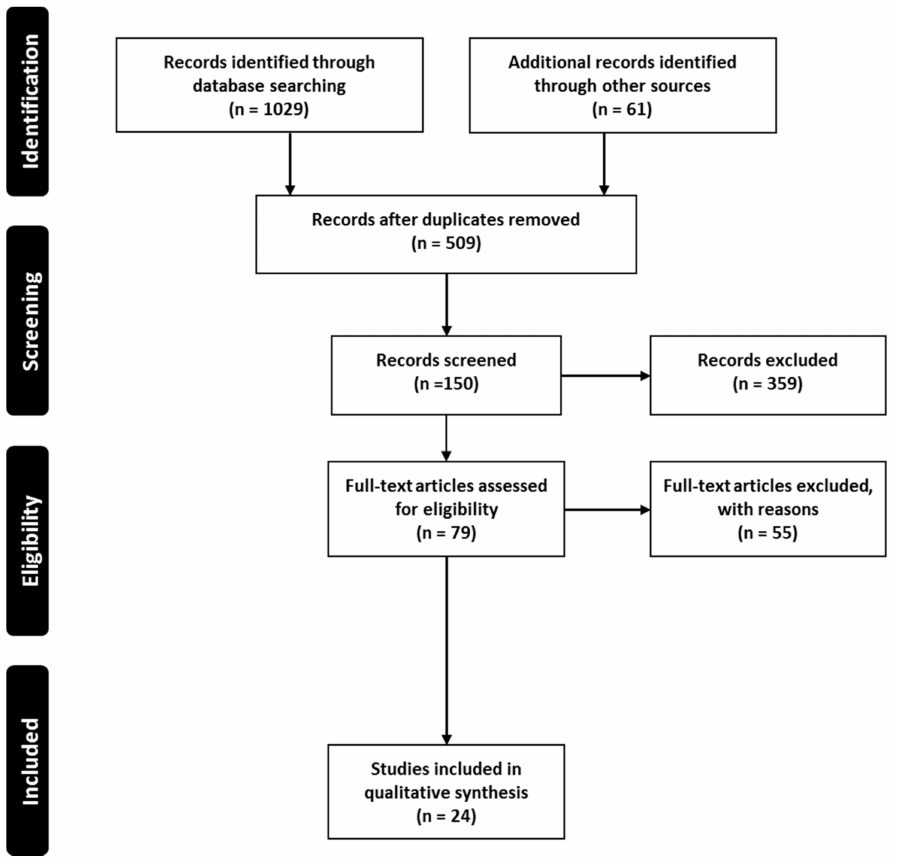
Figure 2. Systematic search and study selection